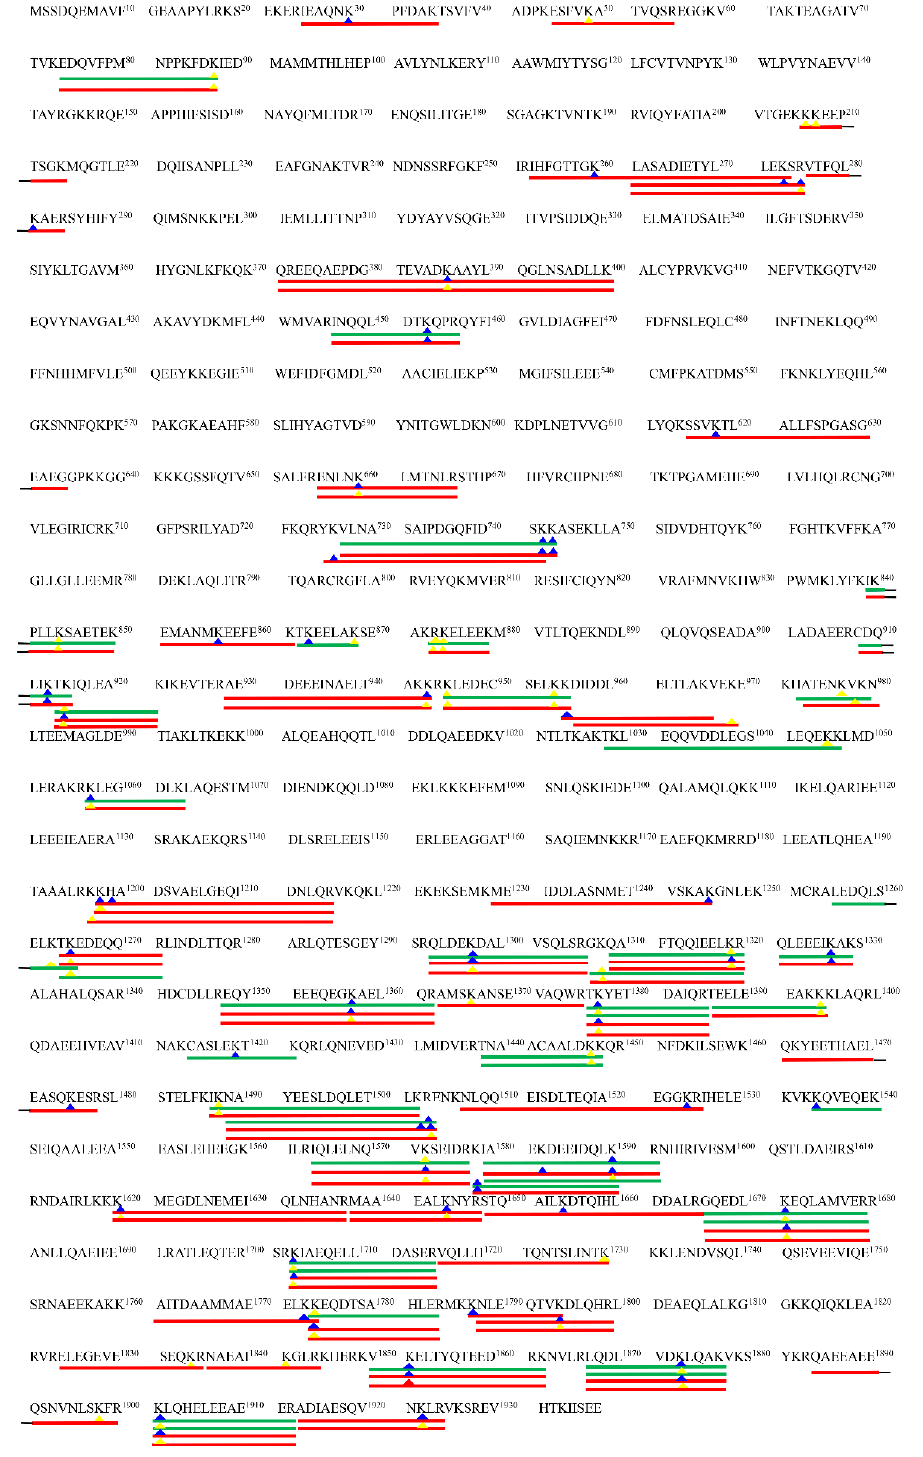
Figure 8. Distributions of the modification sites in myosin-1. The green and red lines indicate the identification of modified peptides in 0.3 mM and 0.7 mM MDA treated samples, respectively. The blue and yellow triangles indicate the binding sites formed with Schiff base and DHP adducts, respectively. The amino acids from the 1st to 844th constitute the myosin-1 head region; the amino acids from the 845th to 1938th constitute the myosin-1 tail